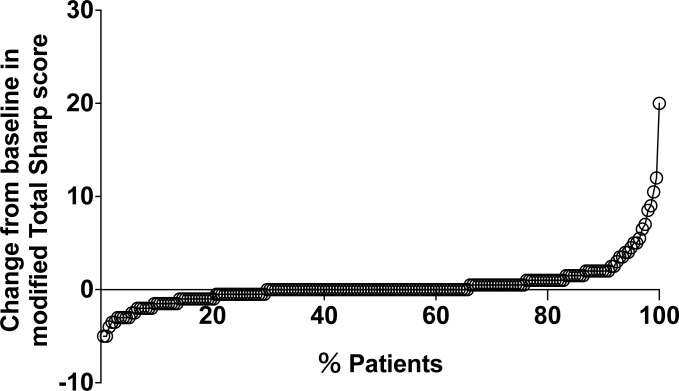
Cumulative probability plots of actual radiographic progression assessed by mTSS (U/year) in the cohort (n = 198).mTSS: modified total Sharp score.